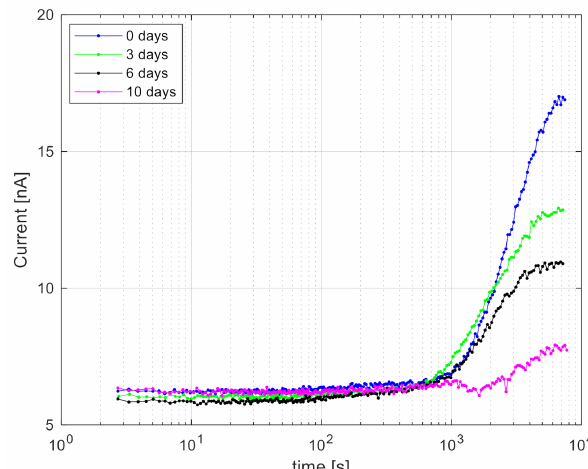
Figure 6. Bioluminescence signal measured as a function of cell culture storage time. Diluted E. coli suspensions were stored for 0, 3, 6, and 10 days at 5 ◦ C, reactivated at 37 ◦ C for 12 h to an OD 600 at 0.1, mixed with 25 µ g L –1 Hg 2+ , and directly measured at room